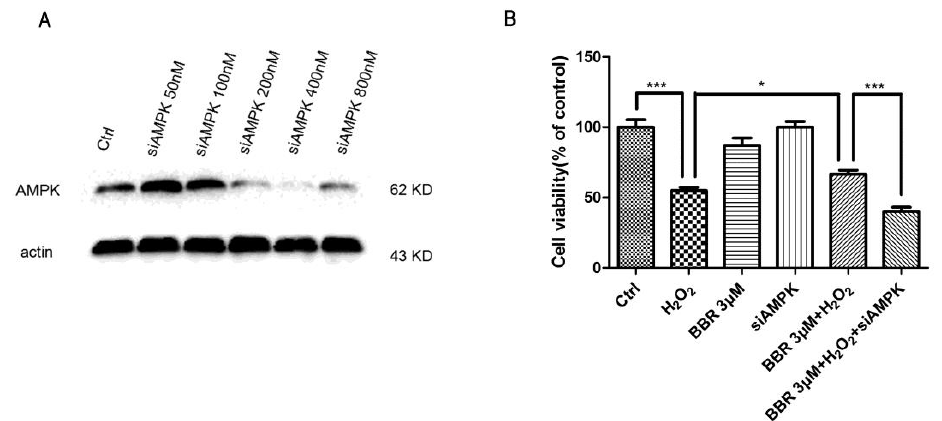
Figure 7. Knocking down the expression of AMPK by siRNA blocked the protective effect of BBR in D407 cells. ( A ) Cells were transfected with different concentrations of siAMPK for 48 h and the expression of AMPK or β-actin was detected by Western blotting; ( B ) Cells were transfected with 400 nM siAMPK, transfected cells were seeded in 96-well, 24 h later treated with 3 µM BBR or 0.1% DMSO (vehicle control) for 2 h and then incubated with or without 100 µM H 2 O 2 for another 24 h. Cell viability were measured by MTT assay. * indicates p < 0.05, *** indicates p < 0.001 was considered significantly different.